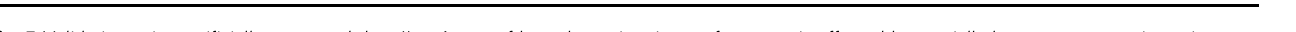
Fig. 5 Validation using arti fi cially generated data II. a A test of how the estimation performance is affected by spatially heterogeneous noise anisotropy resulting from metric anisotropy. Test data were generated by mechanical simulations of elastic membranes (see Supplementary Note 4 – 2 for the details of calculation). b Two potential candidates for tissue evagination were simulated: biased tissue growth ( upper ) and mechanical anisotropy without growth ( lower ). Local deformation dynamics (speci fi cally, the area growth and deformation anisotropy) for both mechanisms were precisely reconstructed and could be clearly distinguished. In the biased growth model, the large area expansion in the growth region was correctly detected, while the degree of deformation anisotropy was low over the whole domain and showed no signi fi cant trend in its direction. In the mechanical anisotropy model, spatial heterogeneity of the area growth rate could barely be detected, and deformation anisotropy along the evagination axis was clearly observed throughout the entire tissue. c The performance of the proposed method was evaluated by examining the prediction errors (cross validation) as well as residual errors. The small prediction error assured the validity of the proposed method. The blue and yellow dots indicate results for the u 1 and u 2 coordinates, respectively. d In addition to the spatial pattern of the area growth rate, the distribution of the direction of deformation anisotropy around the evagination center can also